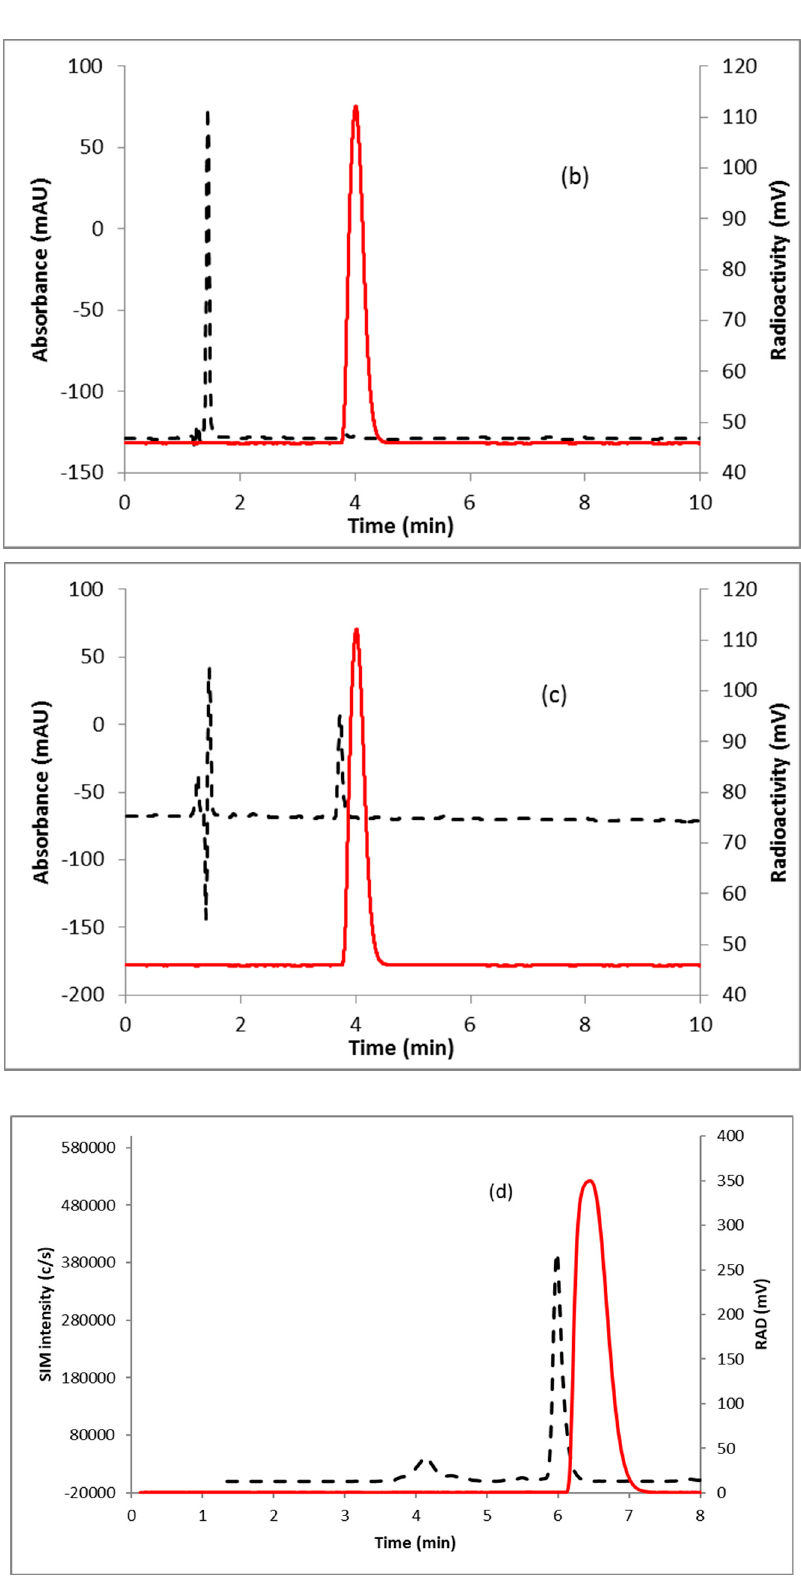
Figure 4. HPLC analysis (method A) of ( a ) crude reaction mixture of [ 18 F]FDHT; ( b ) pure [ 18 F]FDHT; ( c ) [ 18 F]FDHT, co-injected with the non-radioactive standard; ( d ) LC/MS analysis (method E) of [ 18 F]FDHT in SIM mode. Solid line, in-line radiodetector; dotted line, UV detector at 254 nm (for a – c ); for d: dotted line, SIM intensity of m / z 350.